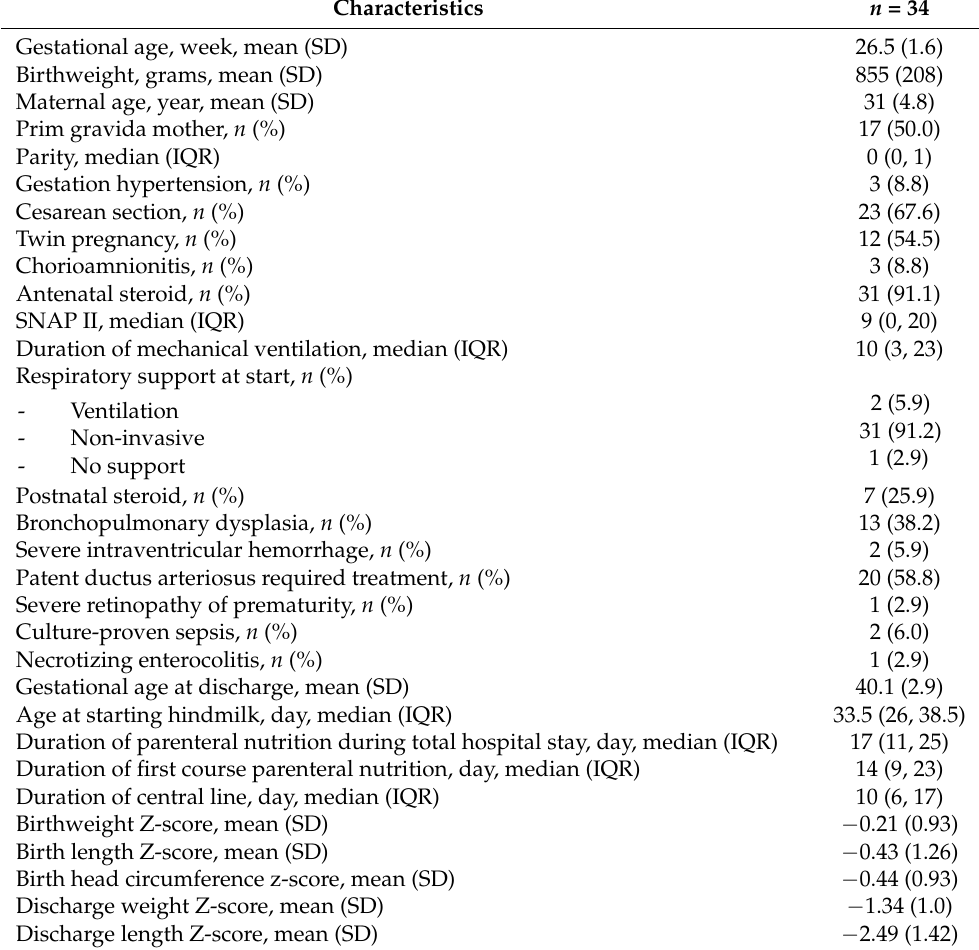
Table 1. Maternal and Neonatal characteristics of study participants.